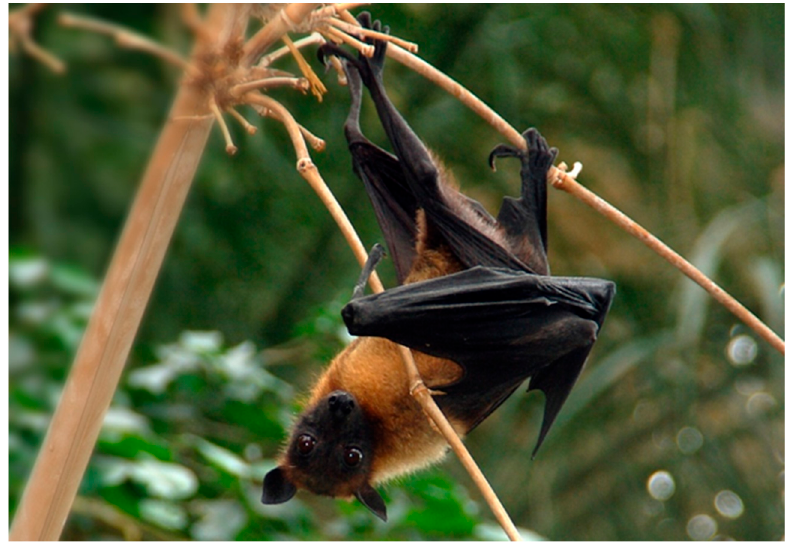
Figure 3. Pteropus giganteus , main reservoir of NiV (Fritz Geller-Grimm, 2002, Zoological Garden Berlin, Germany). This photograph is licensed under the Creative Commons Attribution-Share Alike 2.5 Generic license